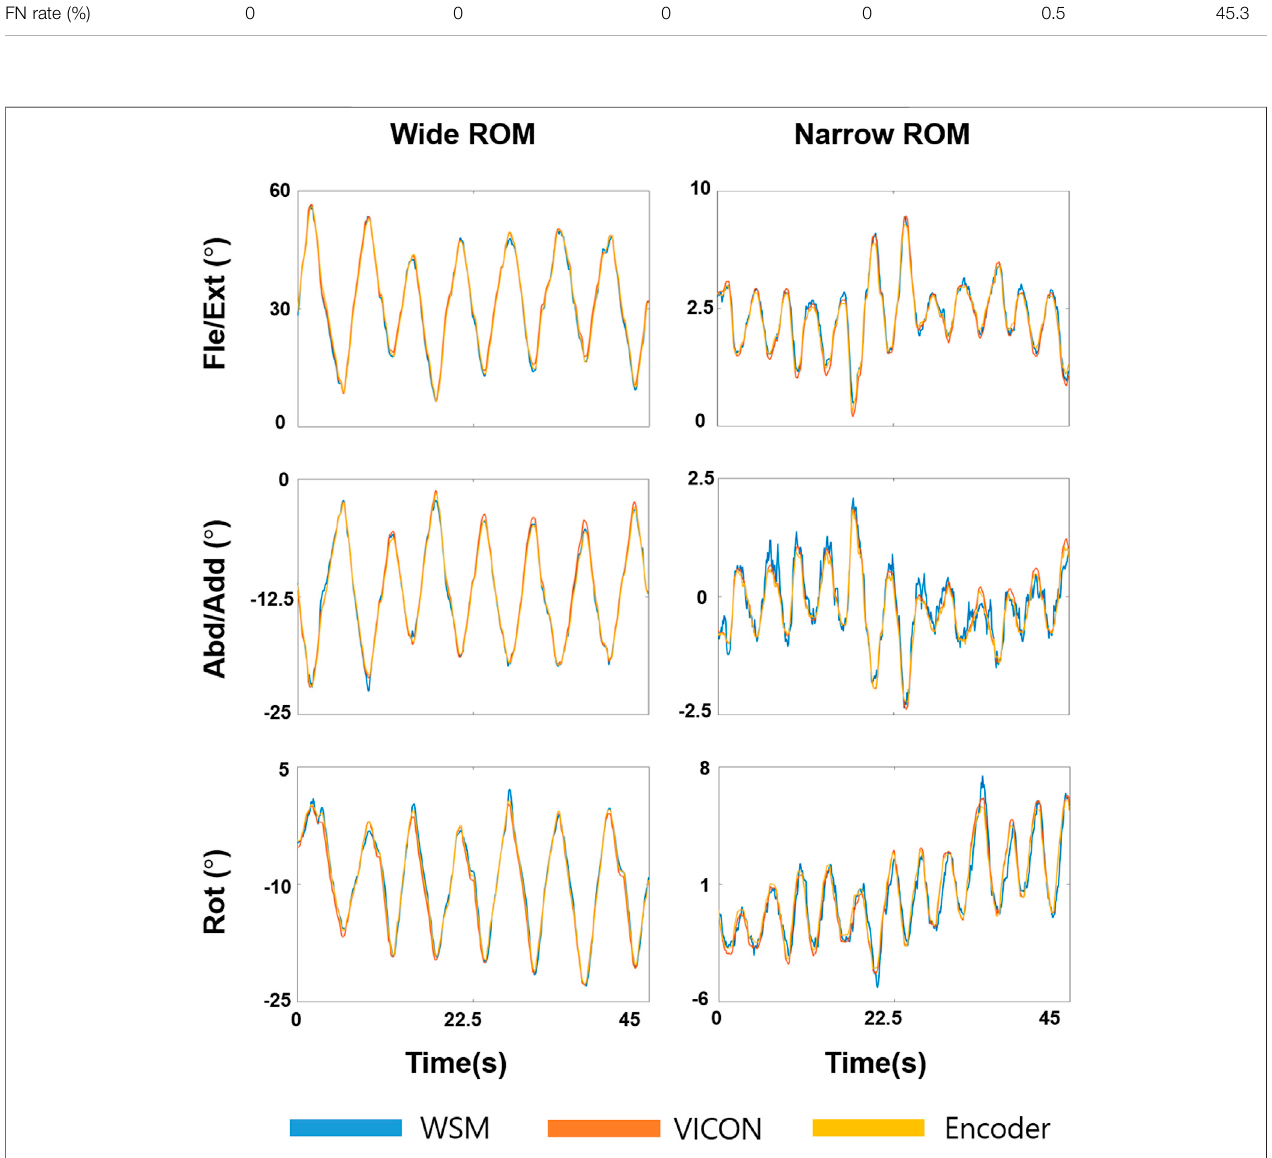
FIGURE 9 | Joint-angle estimation results for the 3-DOF gimbal experiment. Fle/Ext, Abd/Add, and Rot angles were obtained for wide and narrow ROMs. Yellow, orange, and blue respectively denote the encoder, VICON-based system, and WSM system results.